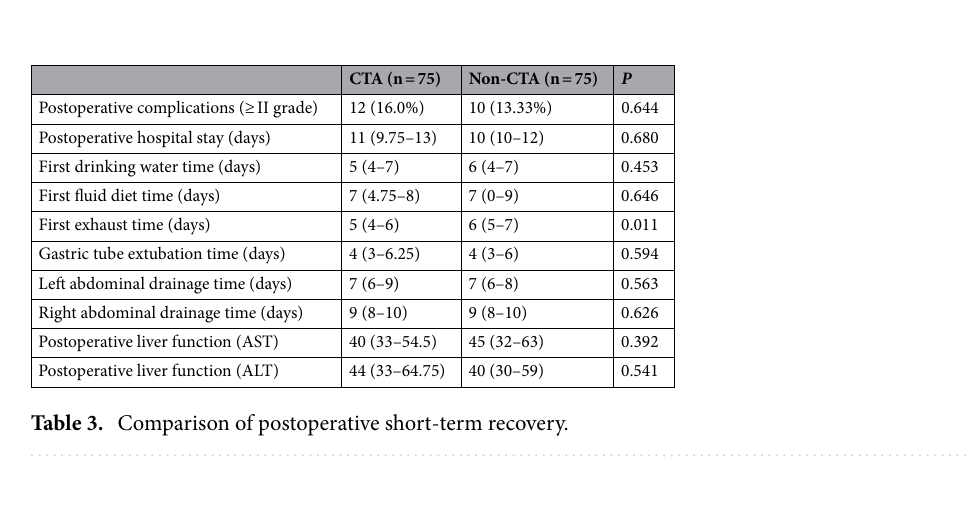
Table 2. Comparison of clinical surgical results. *Data were shown as median and inter-quartile range.